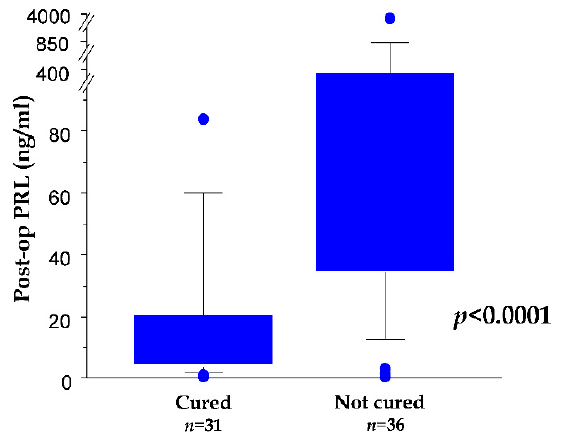
Figure 1. Box plot showing postoperation serum PRL in the subgroup of patients cured vs. not at the end of the 5-year minimum cured at the end of the 5-year minimum follow-up.